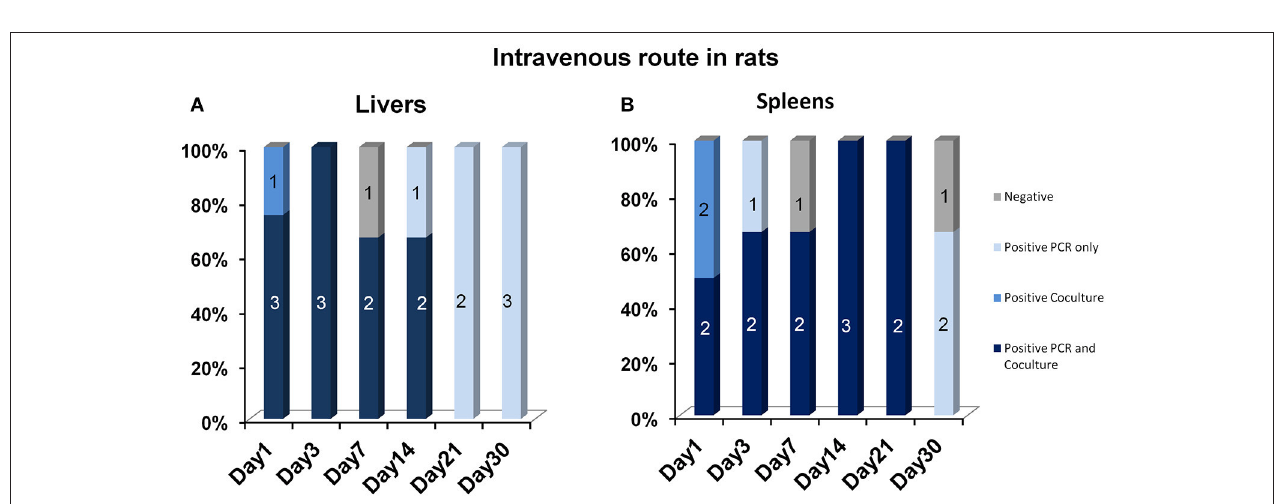
FIGURE 4 | Positive (A) liver and (B) spleen samples, according to the technique (PCR or amoebal co-culture), after intravenous inoculation in rats. The percentage of positive samples is indicated on the y axis. The absolute numbers of positive samples are indicated by labels on the plots.